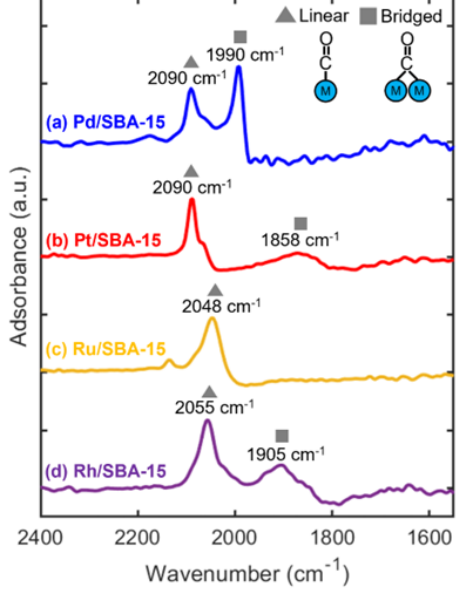
Figure 7. DRIFTS for the CO adsorption on the Pd/SBA-15, Pt/SBA-15, Ru/SBA-15, and Rh/SBA-15. The triangles and squares represent the linear- and bridged-bonded CO on the metals, respectively.